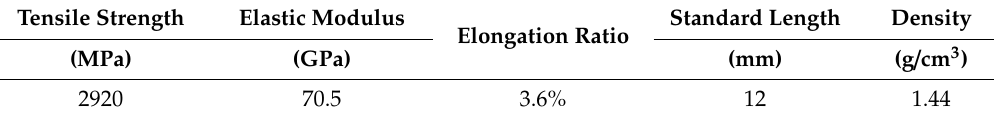
Table 3. Basic physical parameters of KEVLAR fiber.